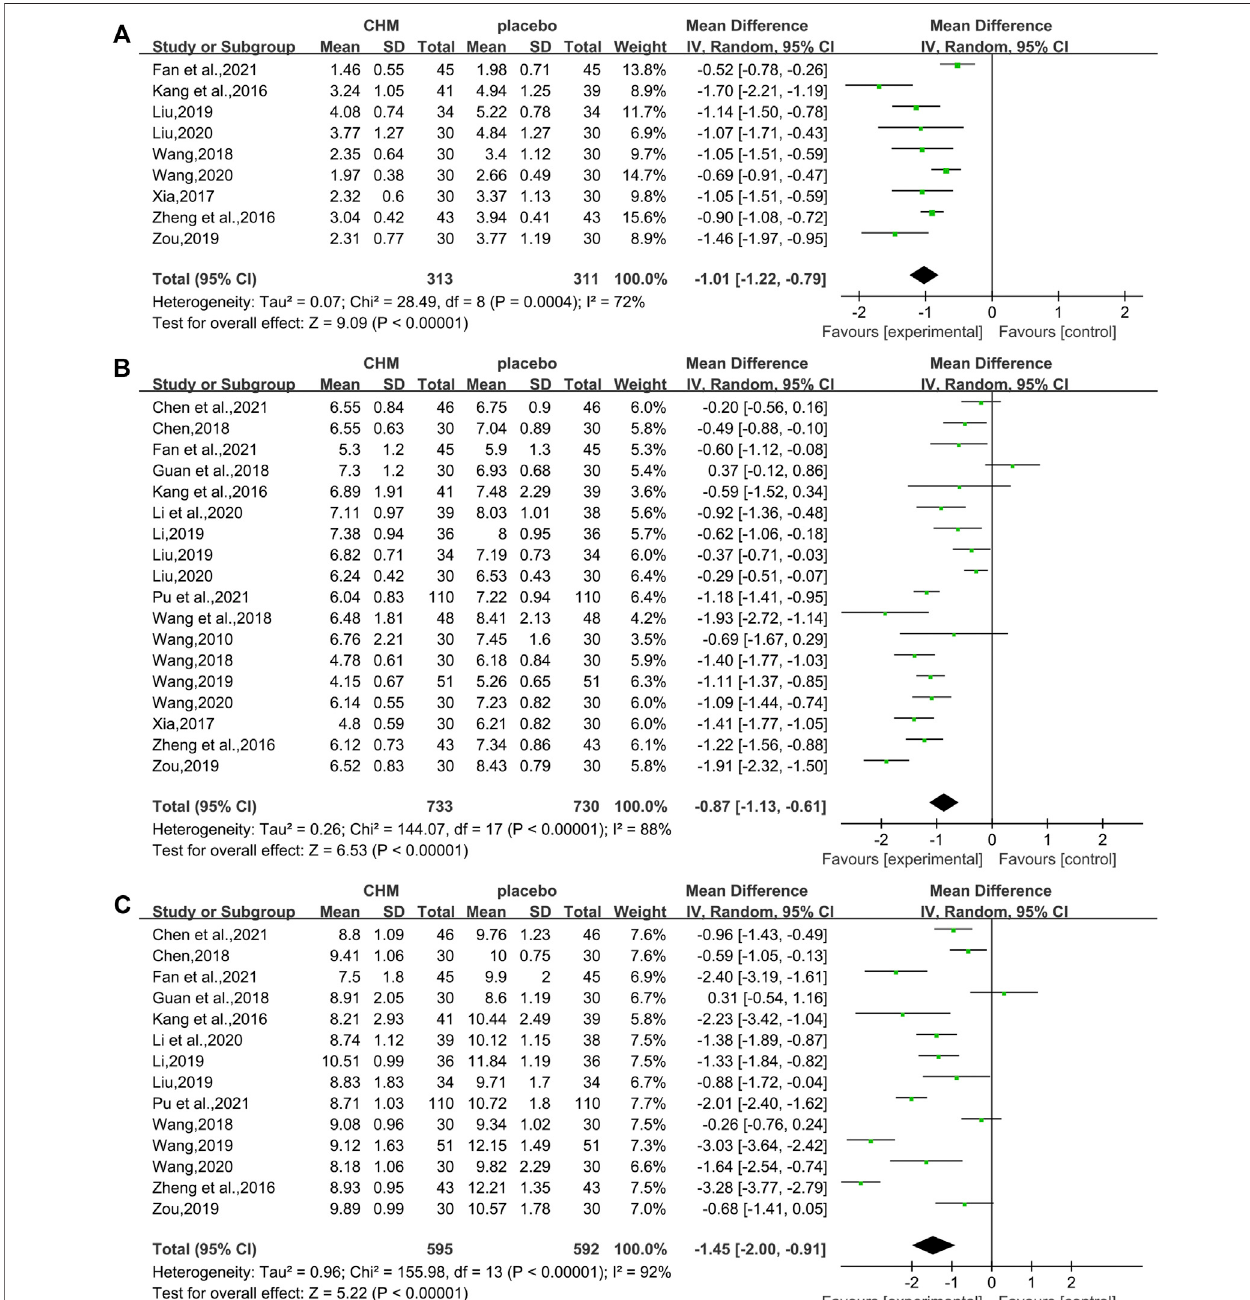
FIGURE 6 | Forest plot for insulin and glycemic indices. (A) HOMA-IR; (B) FBG; and (C) 2hPG.